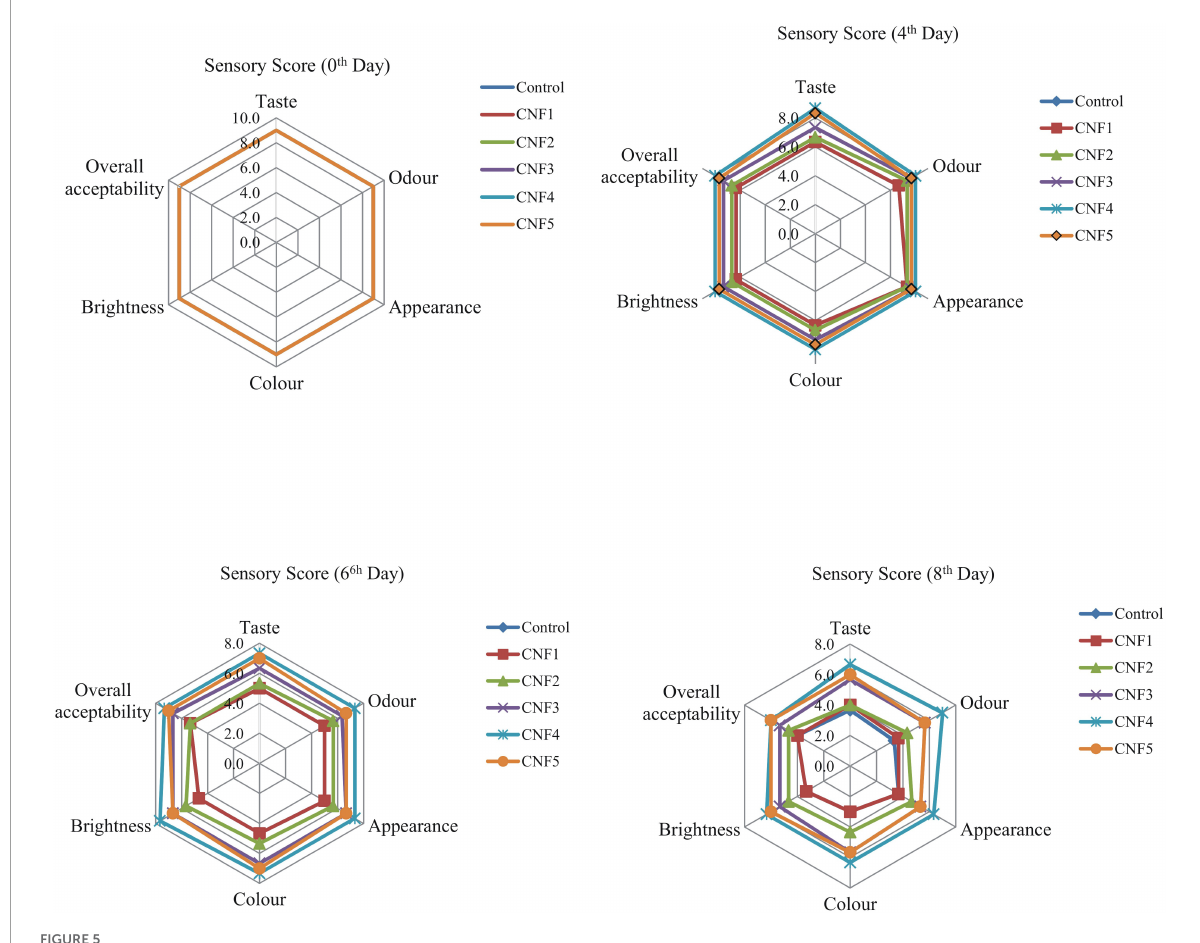
FIGURE5 Sensory score of sapota fruits subjected to various nanomats